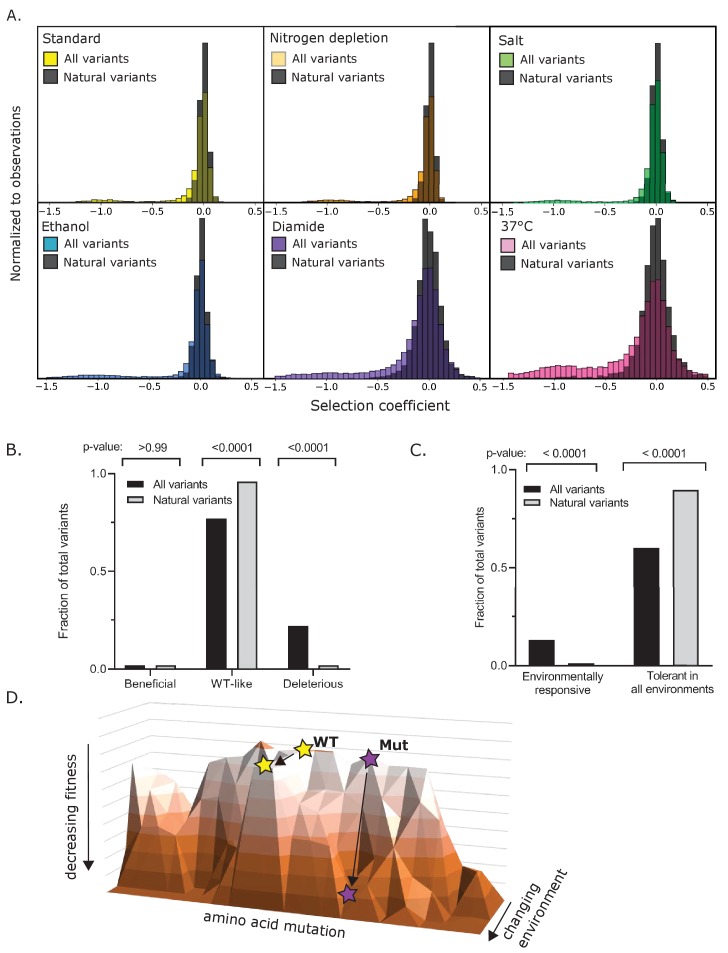
Experimental growth effects of natural amino acid variants of Hsp90.(A) The distribution of selection coefficients of natural variants compared to all variants in each environmental condition (see Figure 6—source data 1). (B) Across all environments, the fraction of natural variants compared to all variants that were beneficial, wild-type-like, or deleterious. (C) The fraction of natural variants compared to all variants that were environmentally responsive or tolerant in all environments. Categories were defined as in Figure 3B. (D) Landscape model indicating that natural variants of Hsp90 tend to support robust growth under a variety of stress conditions.Figure 6—source data 1.List of selection coefficients of all natural variants of Hsp90 in all environmental conditions.